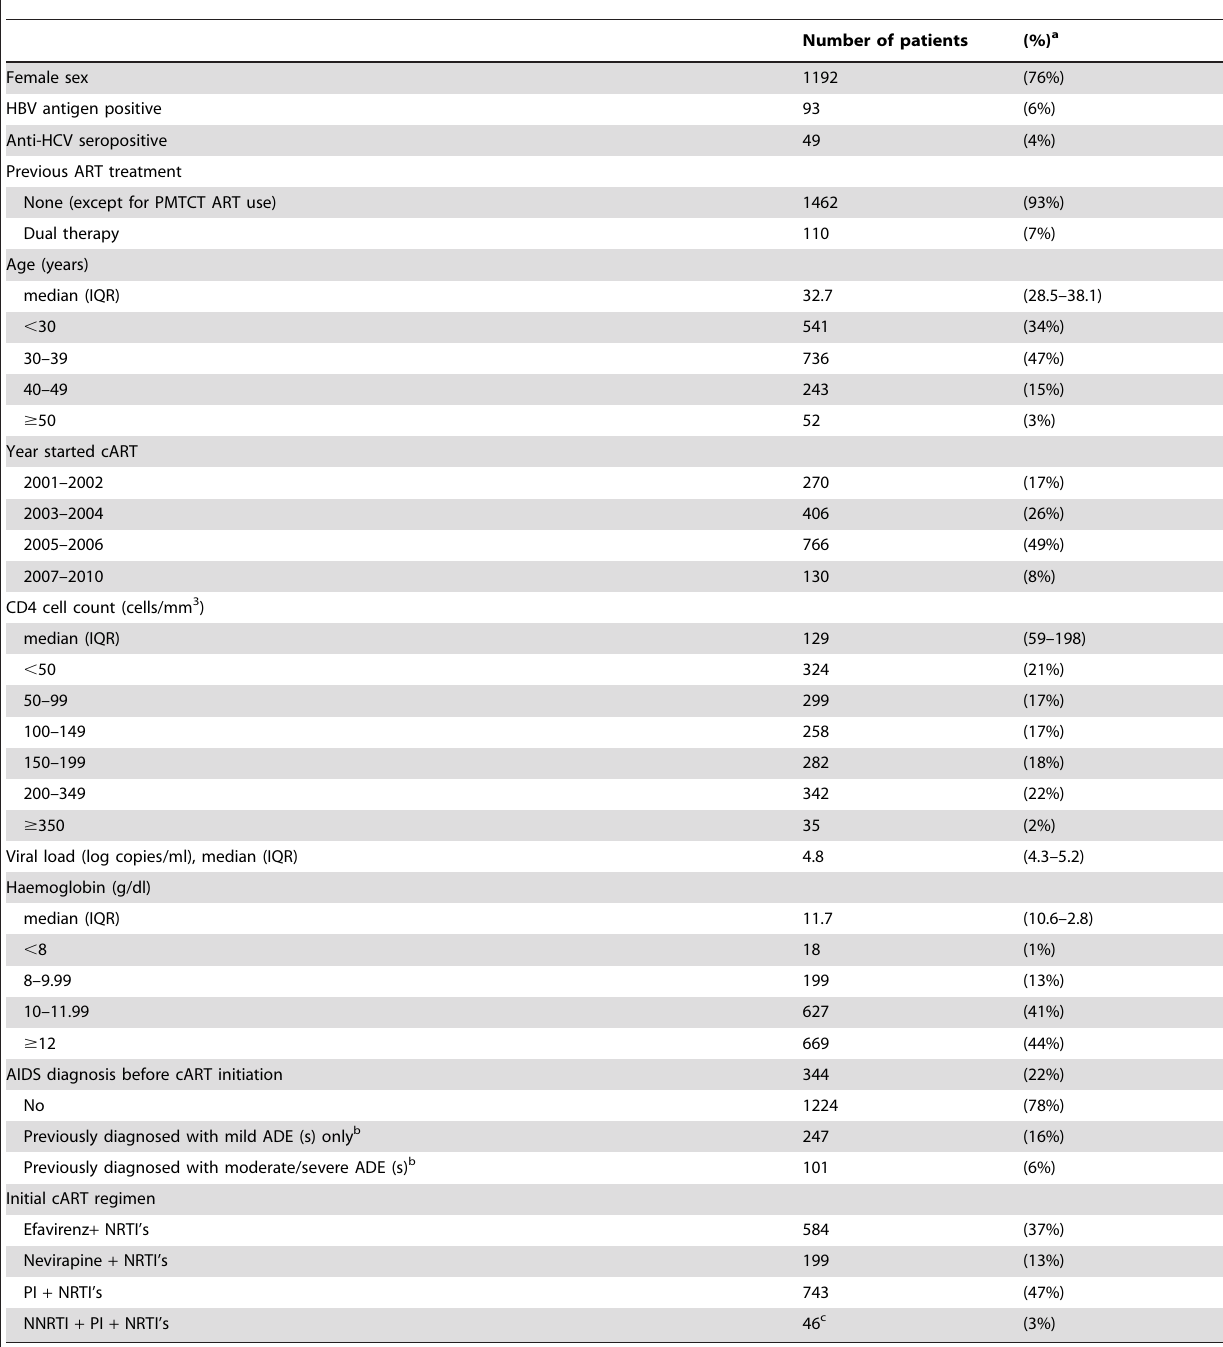
Table 1. Patients’ characteristics at cART initiation (N